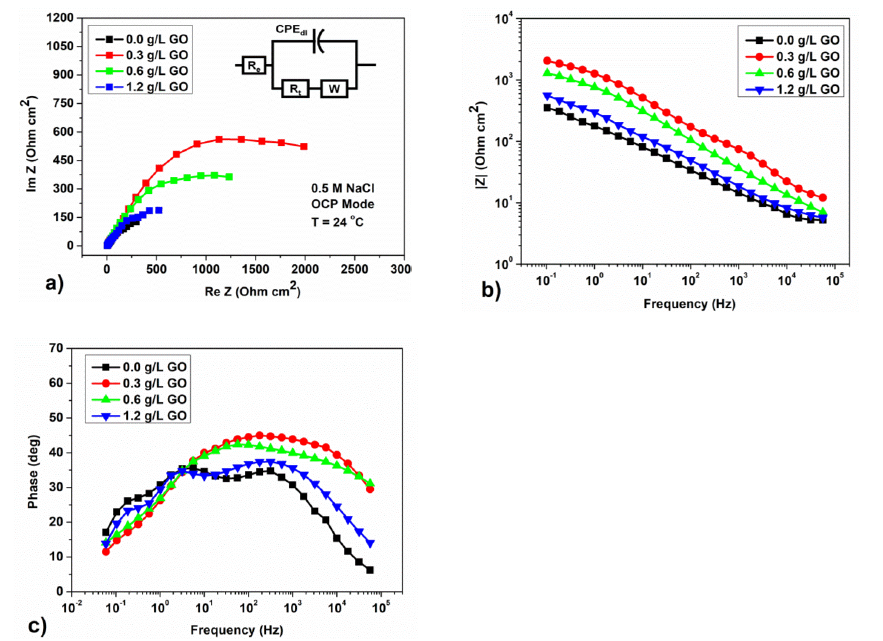
Figure 6. Results of measurements of electrochemical impedance for samples with different con- centrations of GO in a solution of 0.5 М NaCl at OCP; ( a ) Nyquist curves and equivalent scheme for corrosion of steel with a protective coating in a solution of 0.5 M NaCl; ( b ) Bode diagrams; and ( c ) frequency dependence of the phase angle of the electrochemical impedance. According to the authors of [11], the flattened capacitive sector of a circle and a semicircle indicates frequency dispersion due to phosphate defects covering [17,29]. However, as our EIS data show, this statement is valid only for the corrosion process in neutral media. As GO is added into the phosphating bath, the diameter of the circle sec- tor increases until getting to the largest size for GO 0.3 g/L, after which it decreases as the content of GO further increases. It is known that the larger the semicircle’s size, the higher the polarization resistance [30]. This is in accordance with Bode impedance plots, as shown in Figure 6b. The impedance value |Z| exhibits the same changing tendency compared to Nyquist plots. |Z| increases as GO is added, indicating an increase in the corrosion resistance of phosphate coating in a neutral solution. The phase angle ( −θ ) at high frequencies is reported to be useful to evaluate coating integrity as exposed to corrosive electrolytes [31–33]. It is known that the phase angle at 10 kHz indicates the change in coating integrity during exposure to a corrosive electro- lyte. For an intact coating without defects, the phase angle is about –90°, whereas for steel without a protective coating, the phase angle tends to zero [31,34]. As shown in Figure 6c, a higher phase angle in the high frequency range up to 10 kHz, as well as the best corrosion resistance characteristics, were obtained on a sample with an addition of 0.3 g/L GO. The results obtained in [11] also confirm that for the samples with the GO